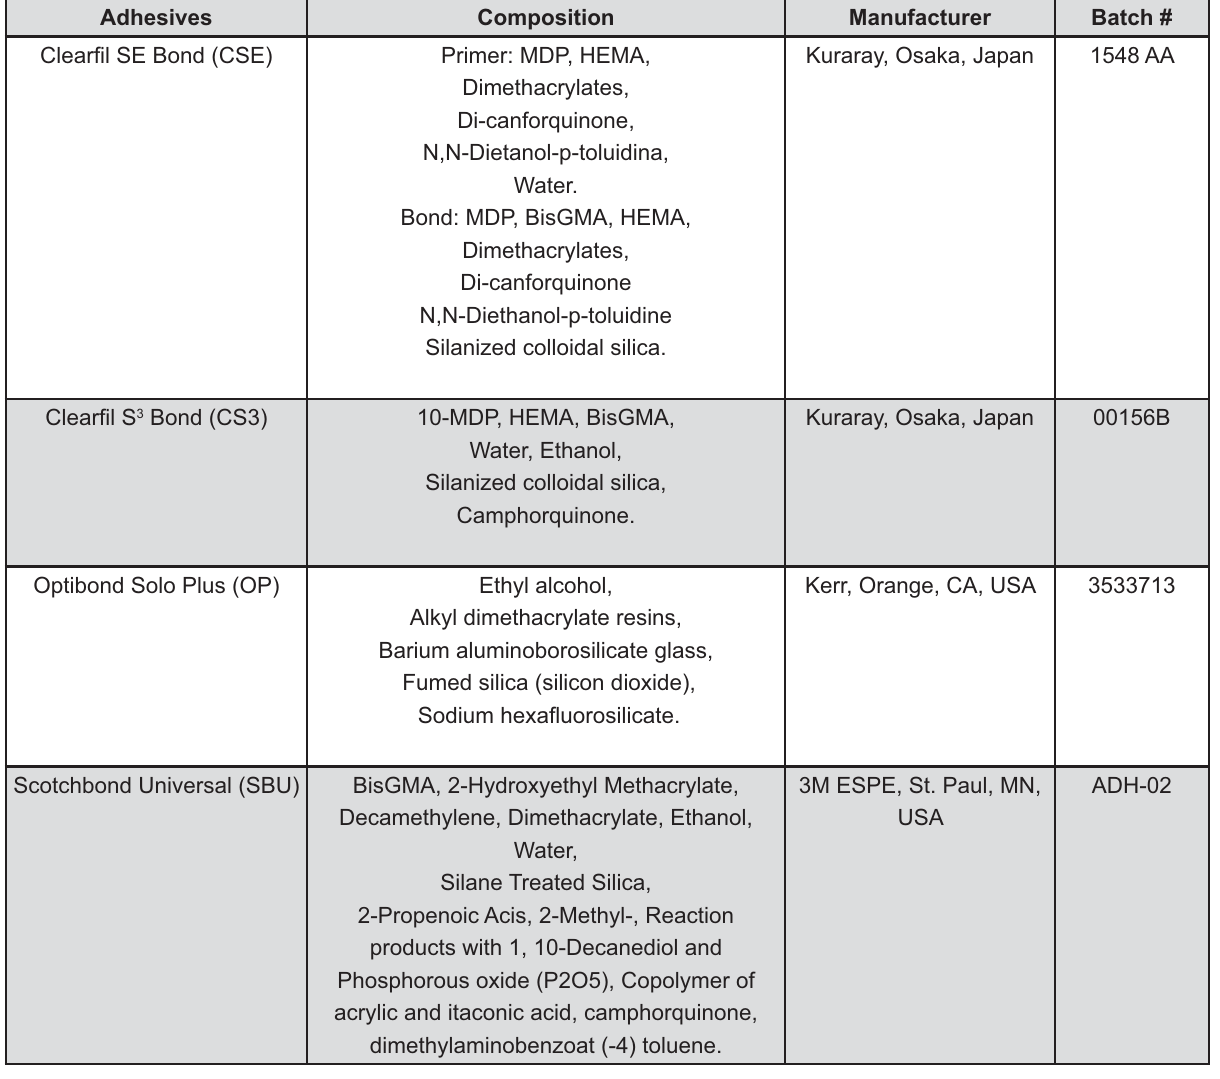
Figure 1- Composition, manufacturers and batch numbers of the adhesives